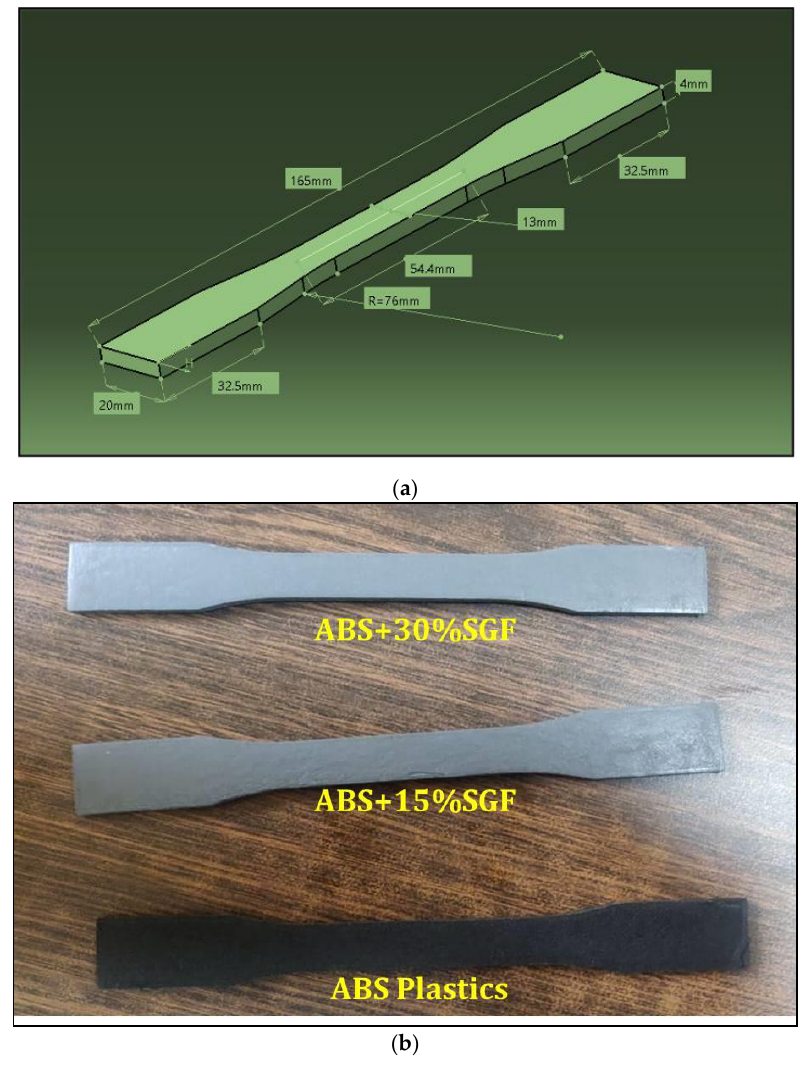
Figure 6. ( a ) Tensile specimen dimensions; ( b ) Photograph of Tensile